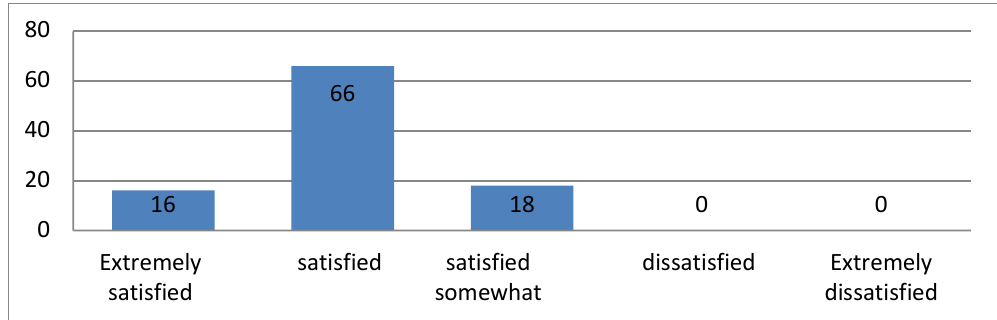
Figure 8: You have opportunities to choose your own job assignments.